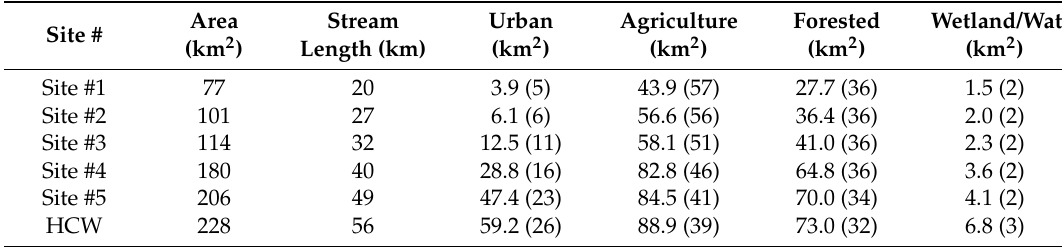
Table 1. Cumulative drainage area, stream length, and land use and land cover area (km 2 ) to each gauging site located in Hinkson Creek Watershed (HCW), Missouri, USA. “HCW” is cumulative of Sites #1 through #5. Cumulative percent land use and land cover (LULC) of drainage area are shown in